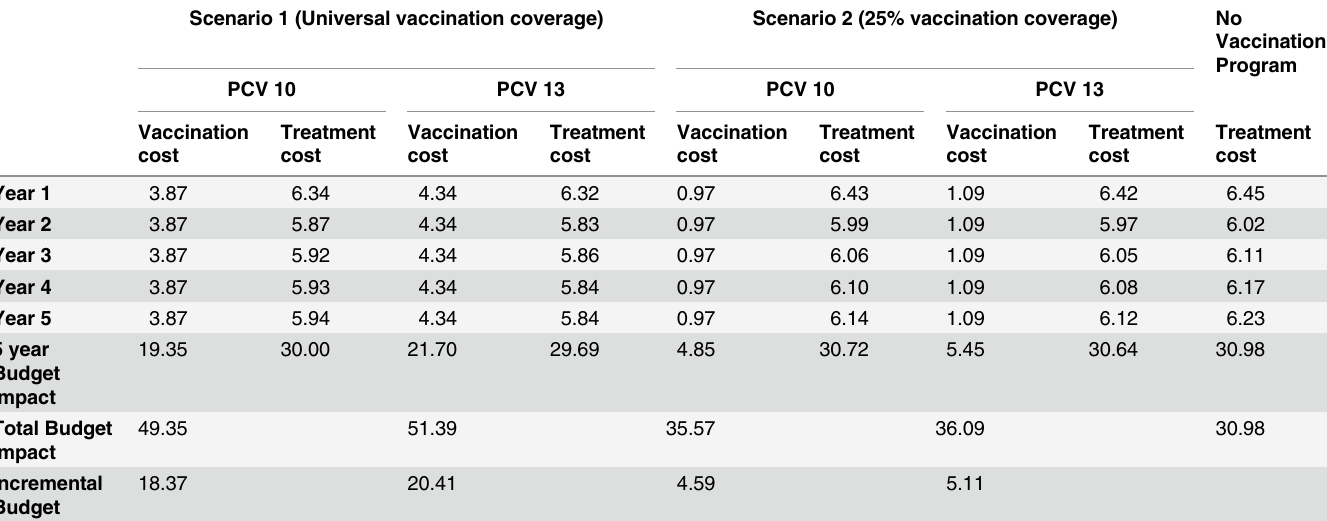
Table 4. Budget impact analysis of scenario 1 and 3 compared to no vaccination in billions (Php). Scenario 1 (Universal vaccination